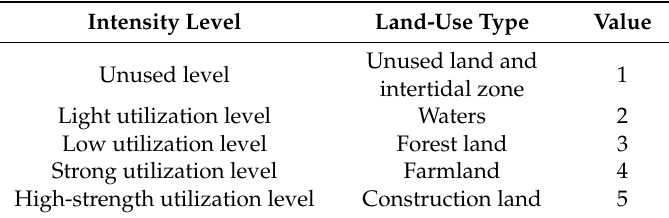
Table 1. Levels of land-use